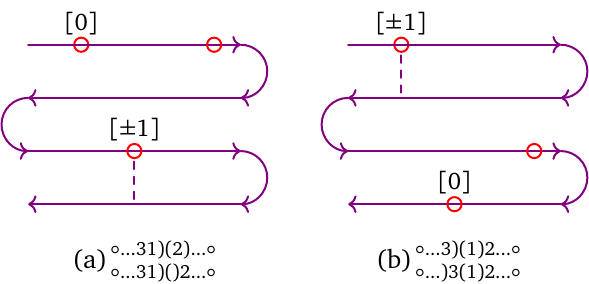
Figure 8: Same three operators in Fig. 7, but now in wing configurations of spread 1. The dashed lines denote the possible positions of operators. There are 4 wing configurations of spread 1.